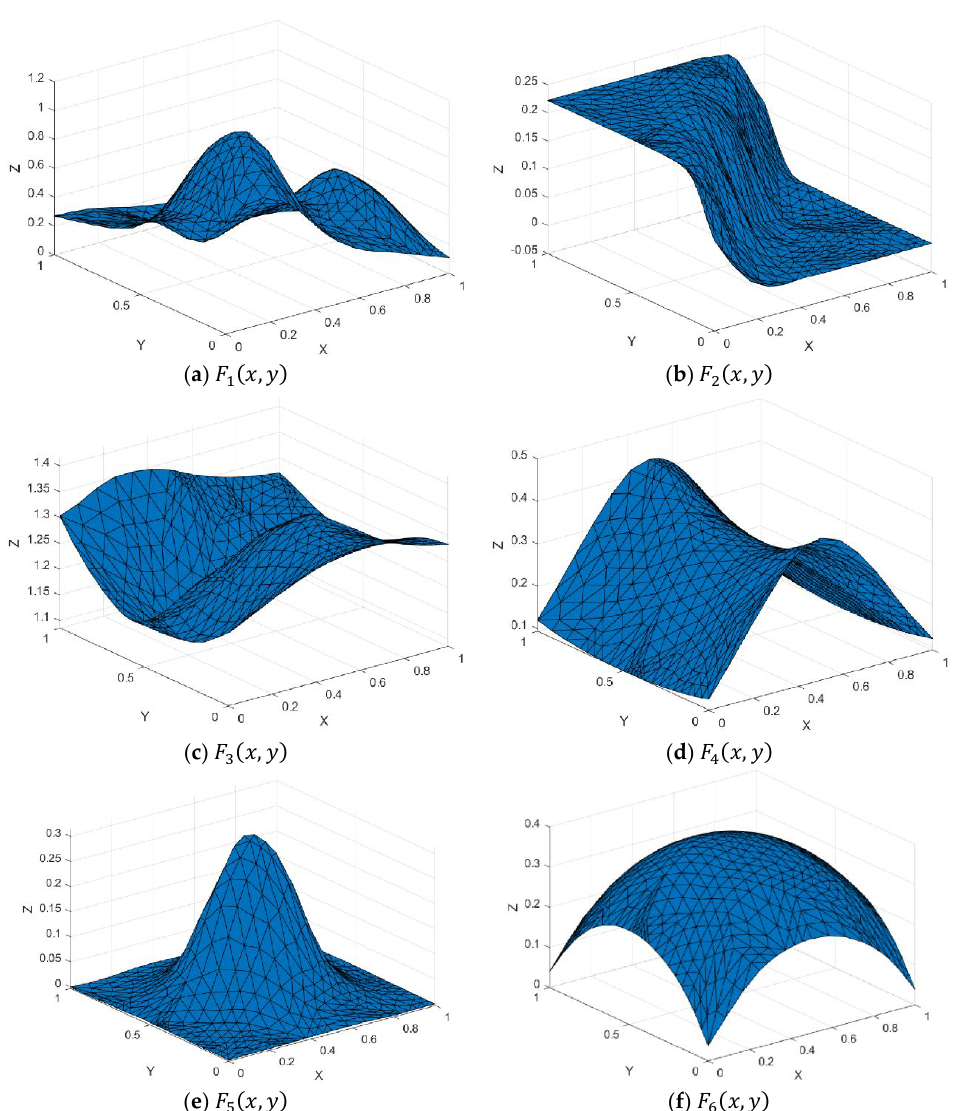
Figure 17. Surface interpolation using Goodman and Said method and Choice 2 for 65 datasets.